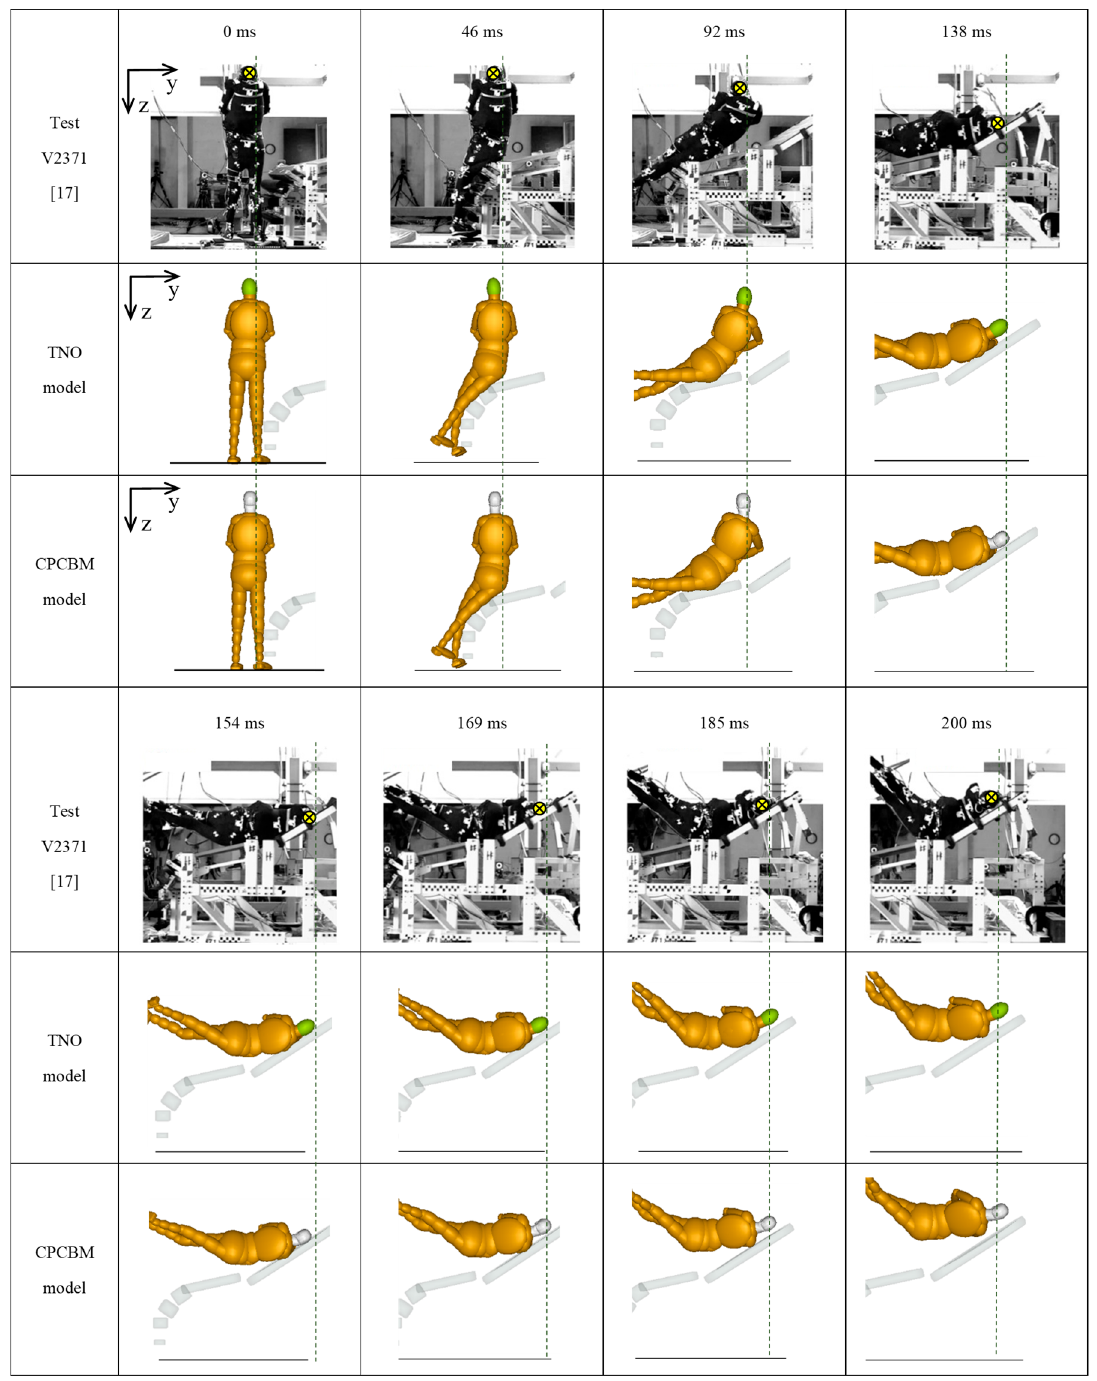
Figure A3. Motion responses of PMHS, the TNO model (gold color), and CPCBM (mixed color) for test V2371 (posterior view) [17].